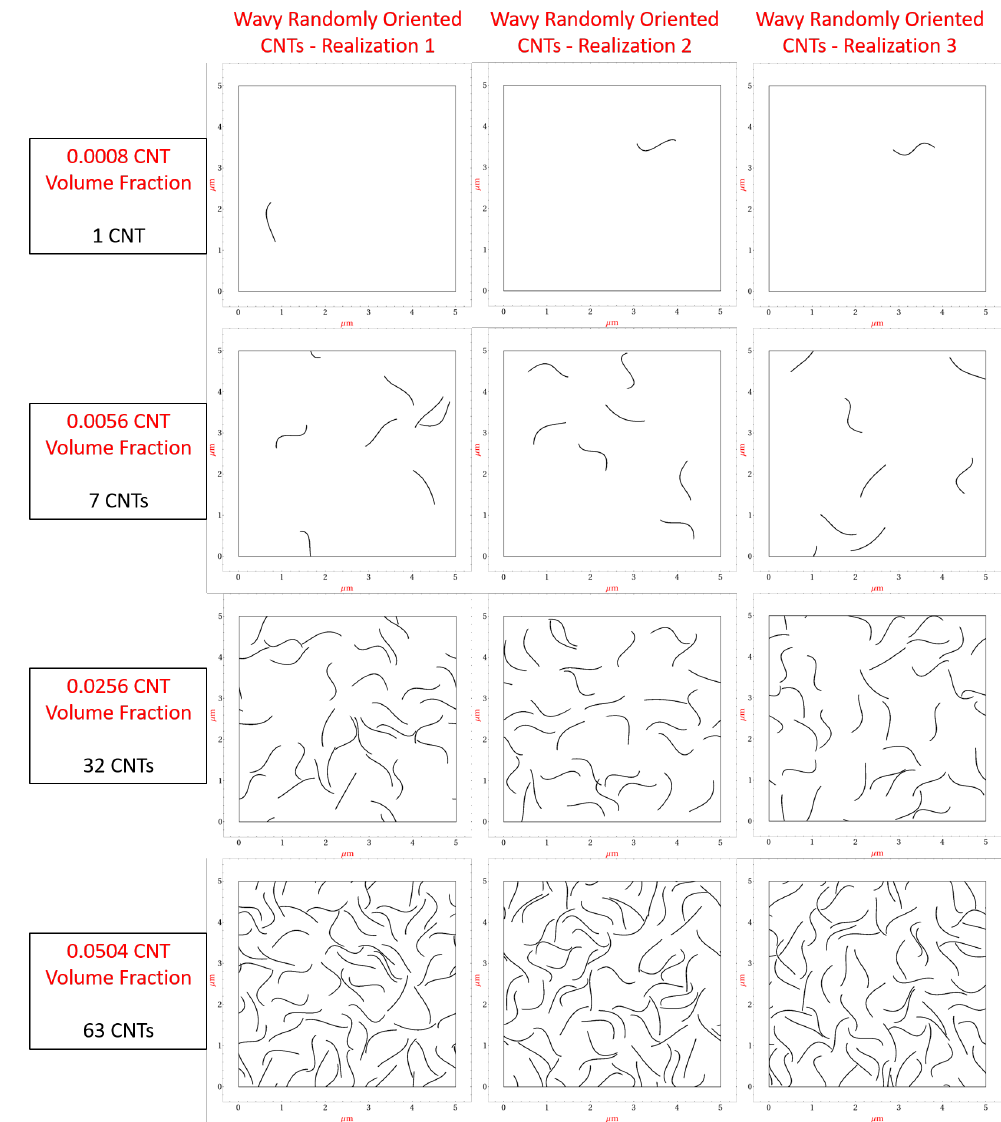
Figure 5. First three realizations generated for CNT volume fractions 0.08%, 0.56%, 2.56% and 5.04% for the randomly oriented orientation condition with wavy